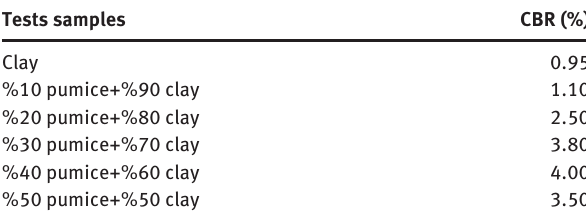
, compacted unit weight. (C) CBR. (D) P comp